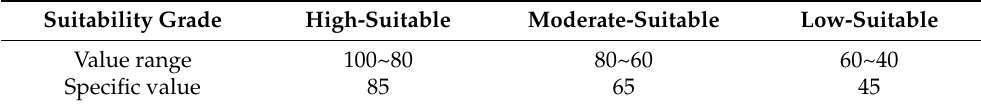
Table 2. Values of single factor index.